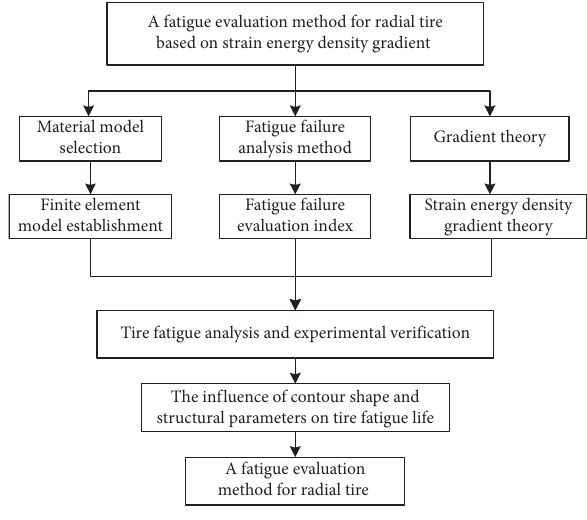
Figure 1: Flowchart.